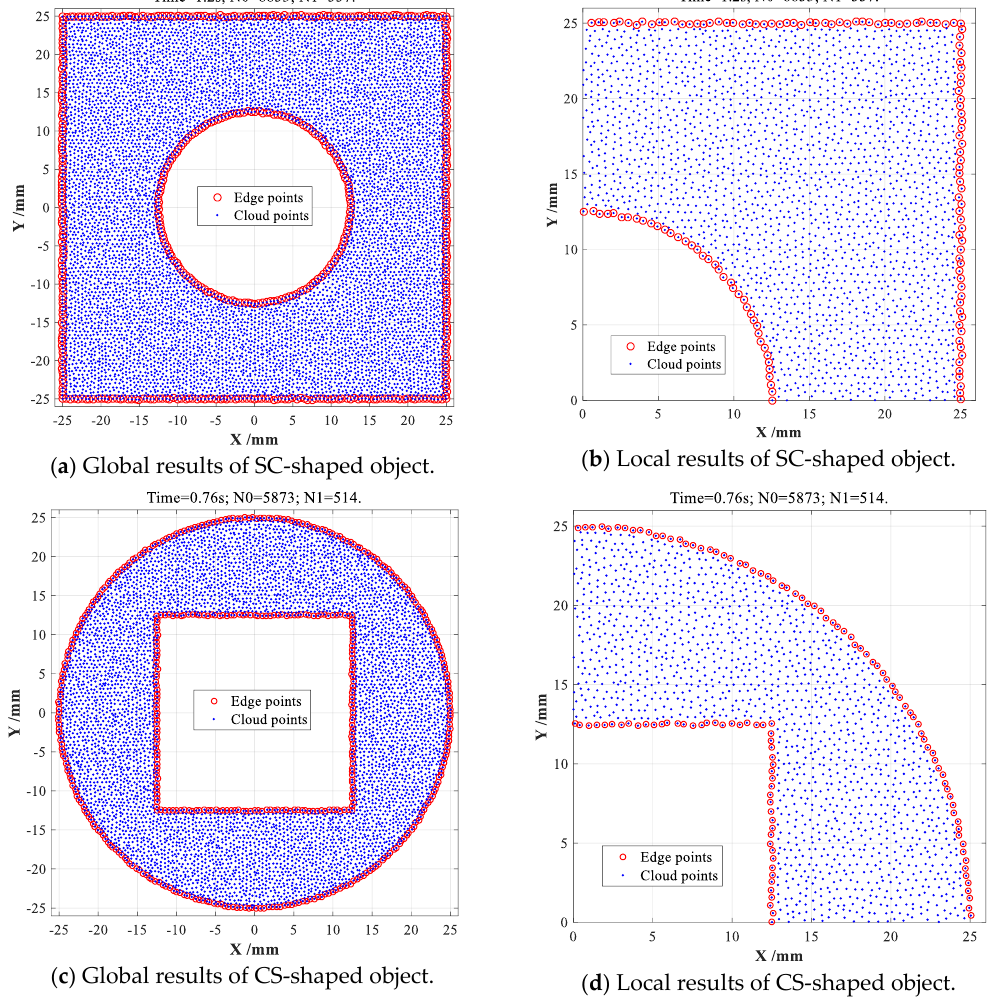
Figure 5. Boundary extractions on two different point cloud datasets with CDTM-based method.